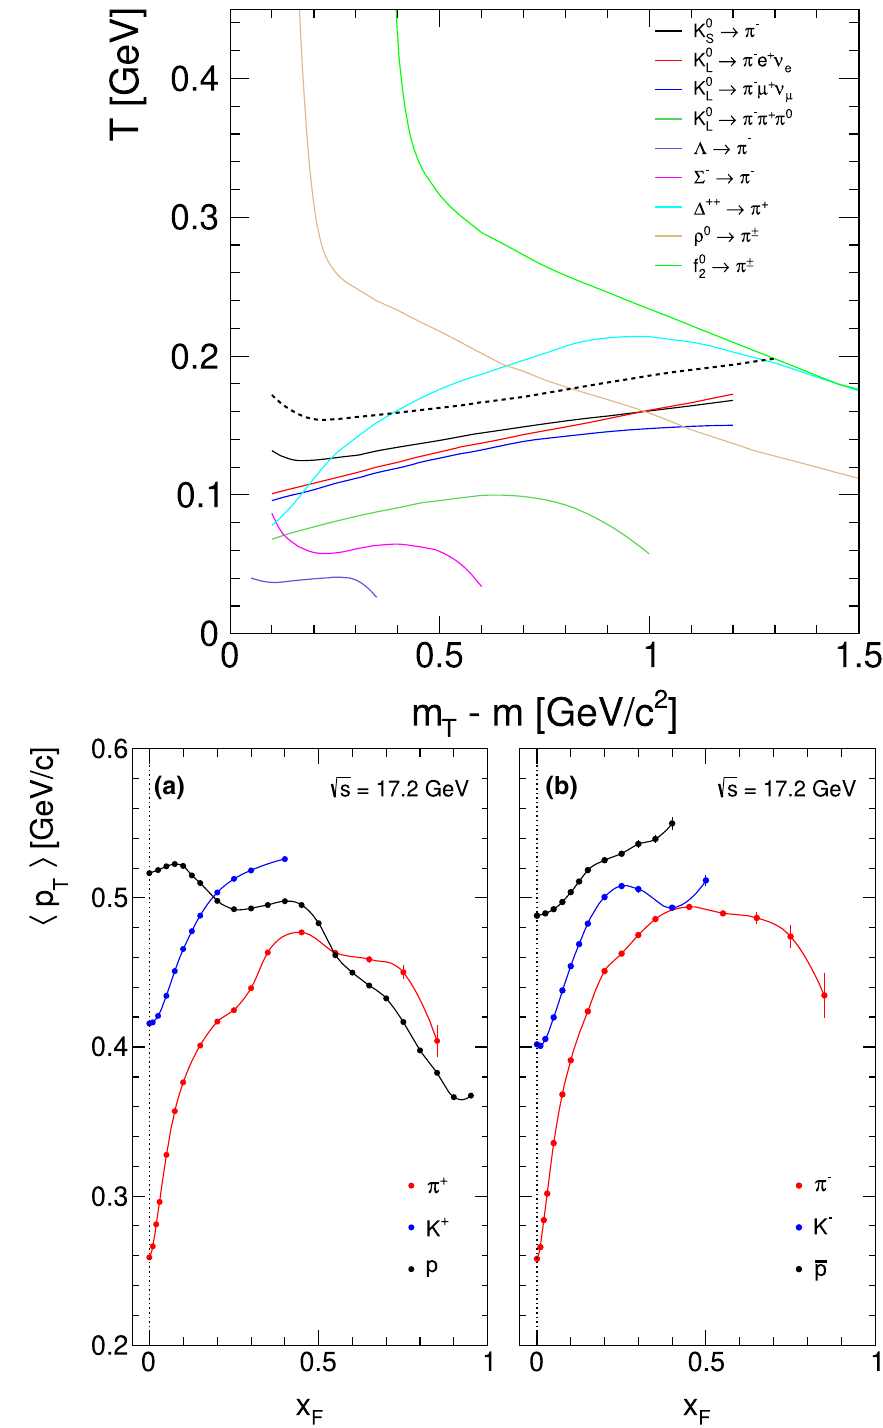
Fig. 174 Inverse slopes T (GeV) as a function of transverse mass at central rapidity and p beam =158 GeV/c for decay pions from different baryonic and mesonic resonances. The measured inclusive value for pions is indicated by a thick dashed line